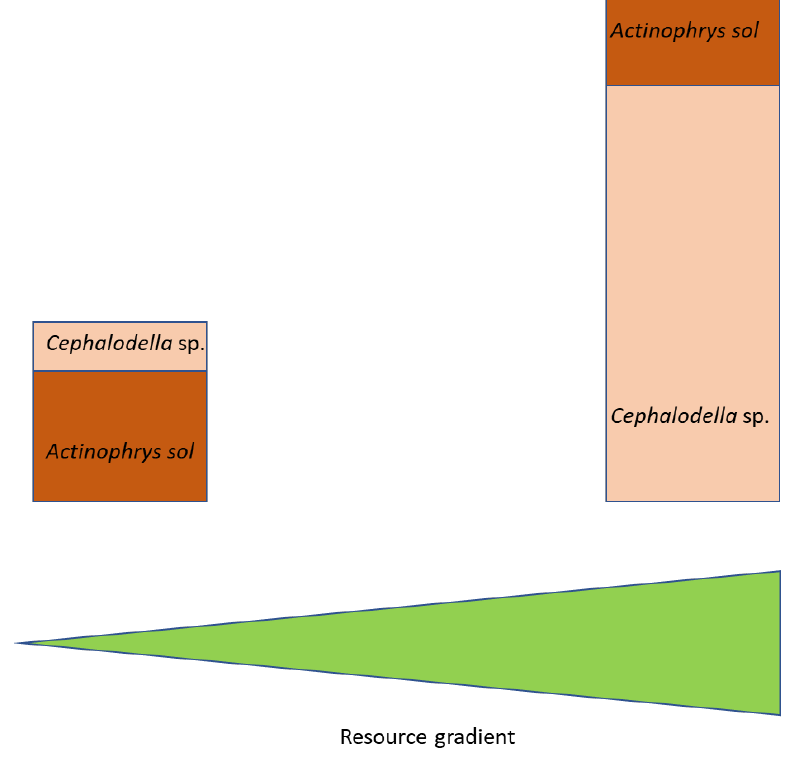
Figure 4. Schematic representation of the relationship of resource availability and consumer and predator abundance.